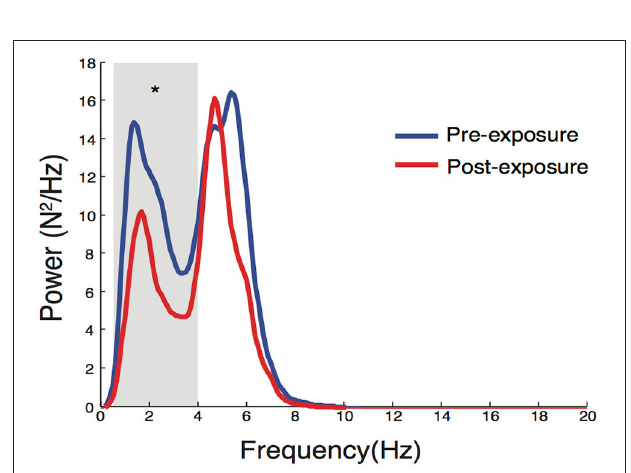
FIGURE 9 | Changes in power spectral properties in LED compression force after eccentric contractions. There was a significant reduction in LED 0.5 − 4Hz ( p = 0.027), while no significant change was observed in LED 4 − 8Hz . *Denotes significant change ( p <